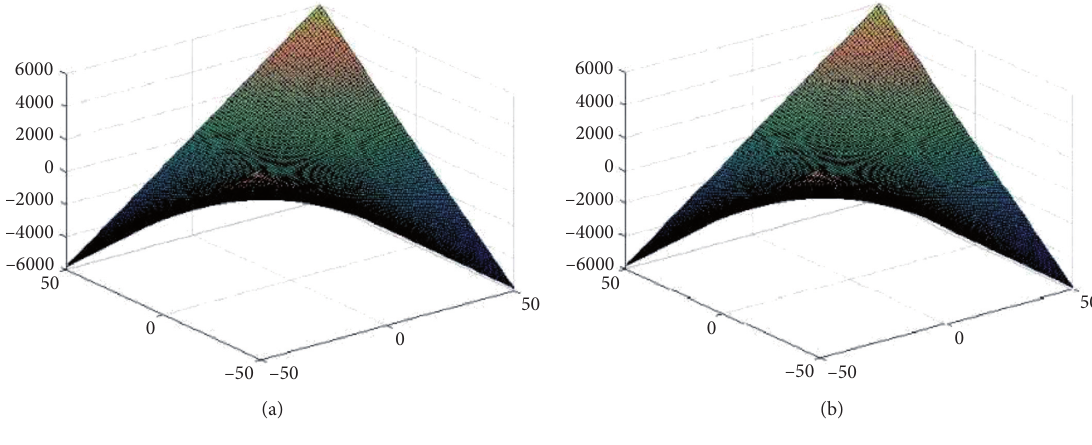
Figure 9: Harmonic index plotted in 3D.